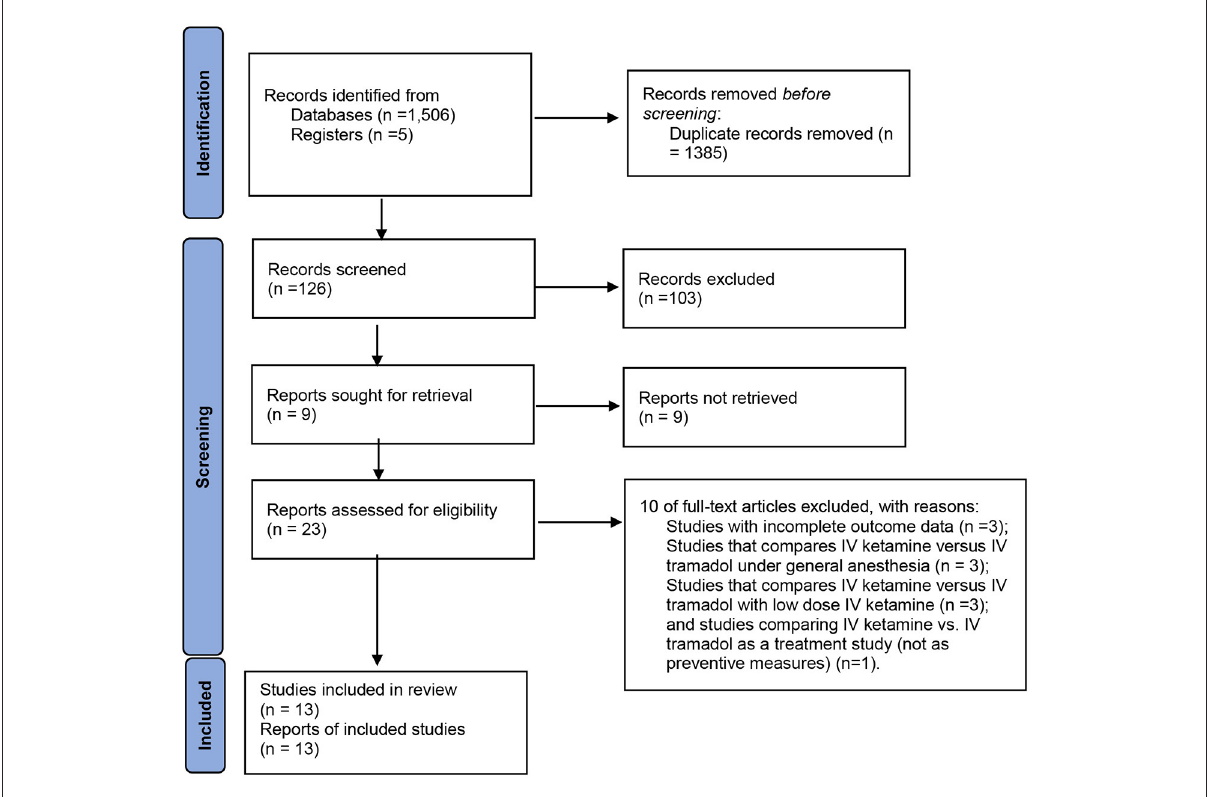
FIGURE2 PRISMA 2020 flow